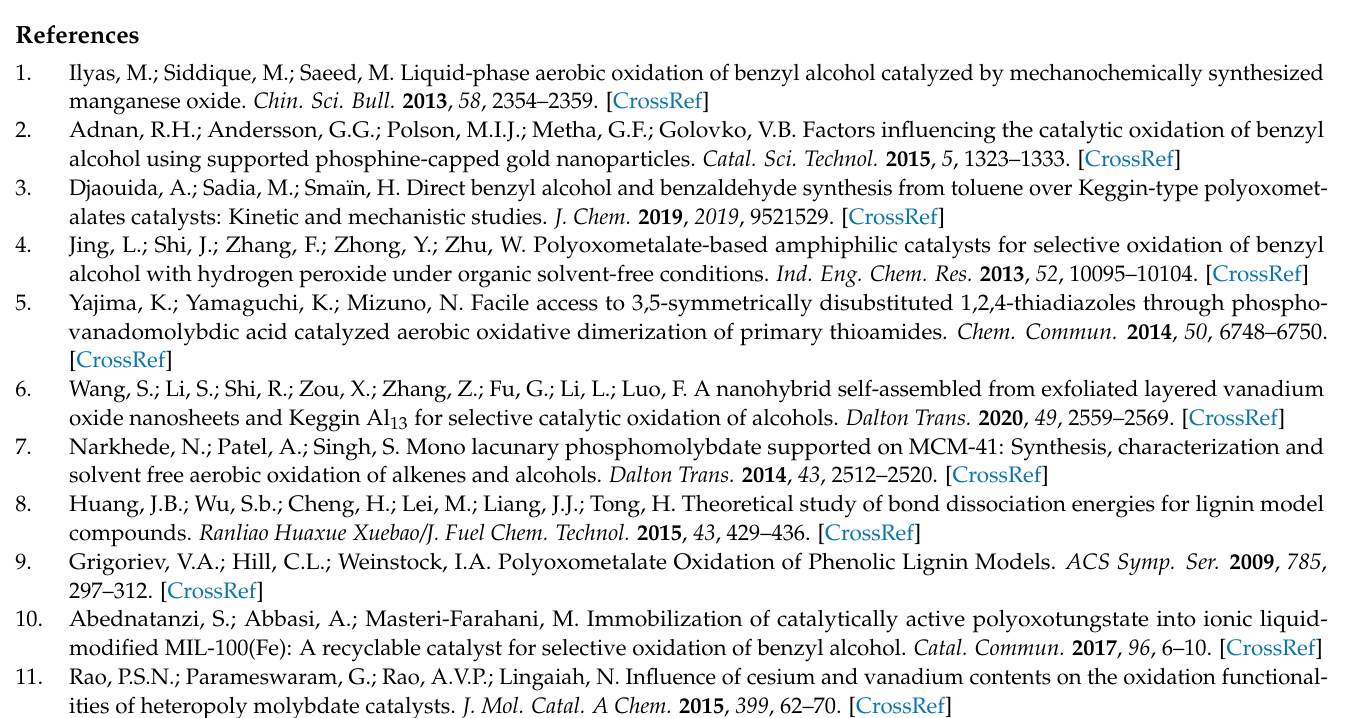
Figure A3. First-order kinetic analysis plot for the liquid-phase aerobic oxidation reaction of benzyl alcohol over time for the pure and substituted Mo and W catalysts.